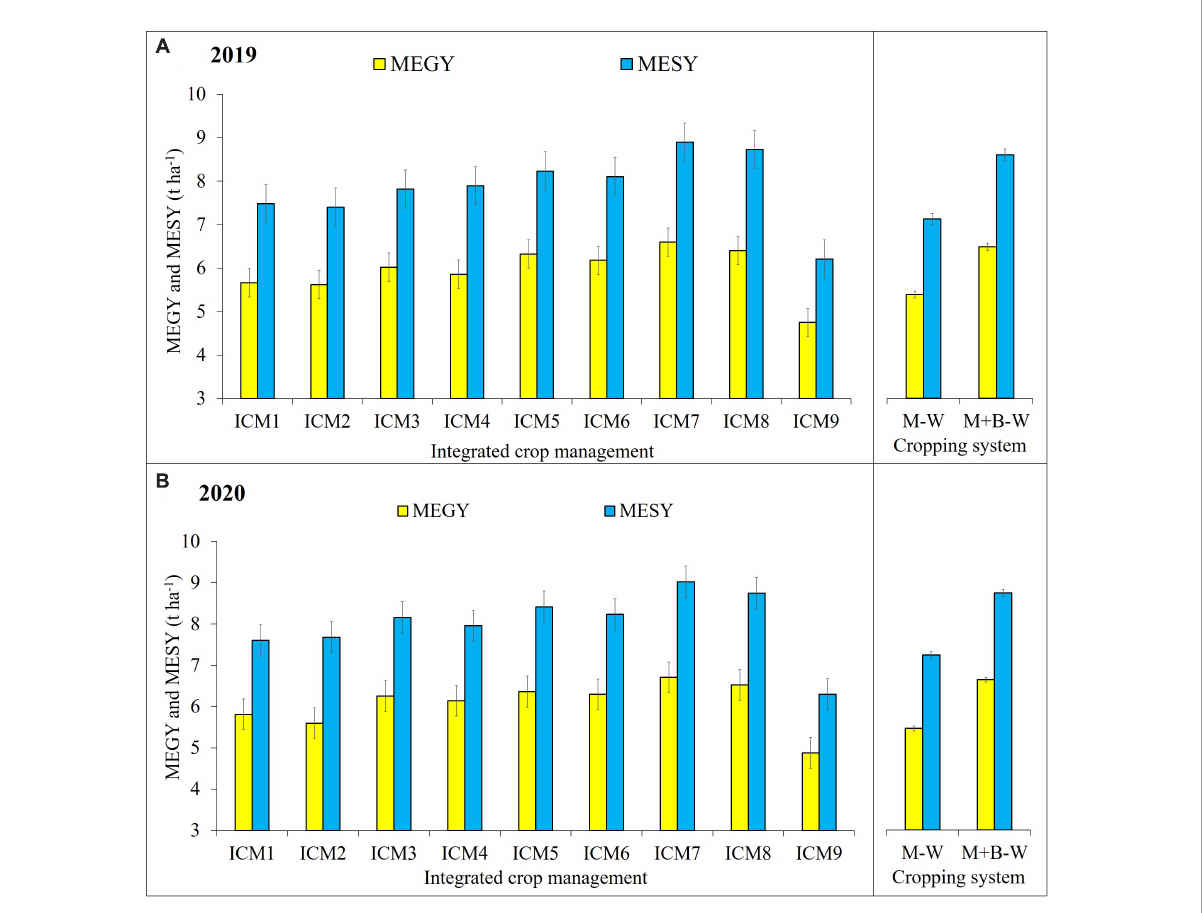
FIGURE4 Effect of different ICM modules and cropping system on maize equivalent grain yield (MEGY) and maize equivalent stover yield (MESY) 2019 (A) and 2020 (B) . The LSD 0 . 05 is denoted by a bar above each column, and any treatment beyond the range of bar within each year is significantly